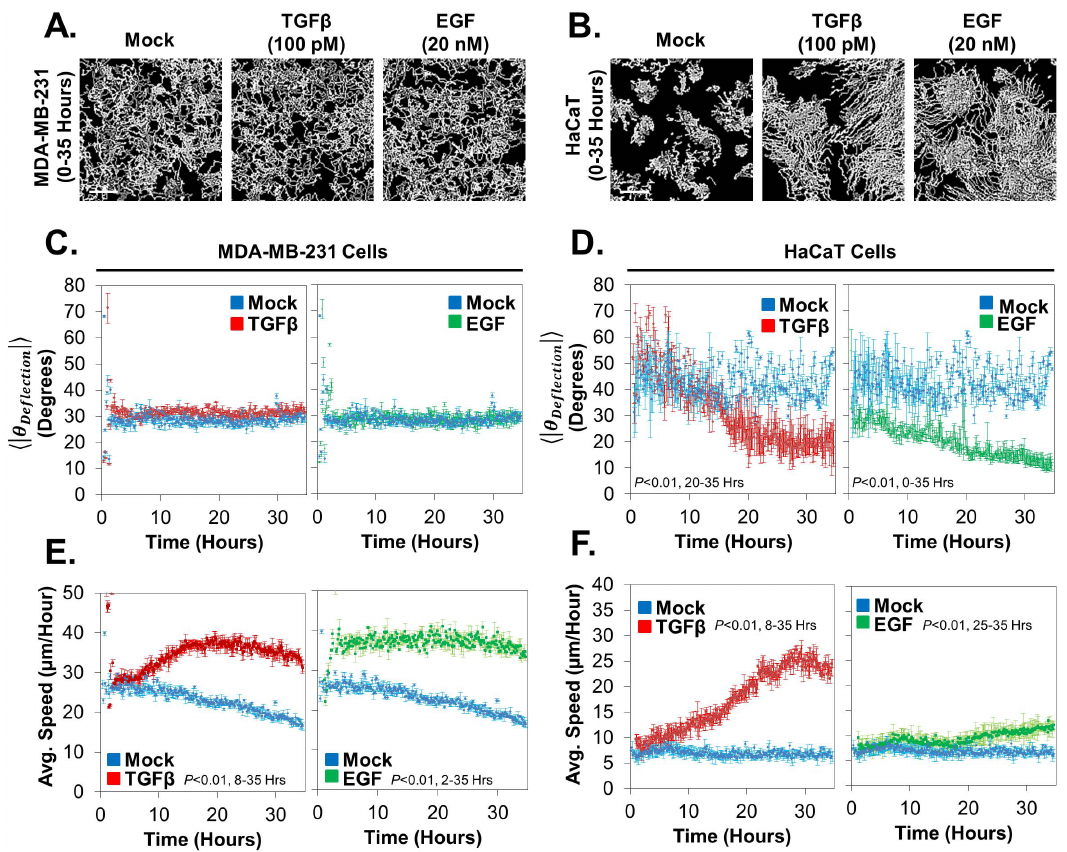
Figure 5. Measuring individual cellular behavior with speed and migration persistence reveals cell type and ligand specific cellular migration behavior. Cellular tracks of low density cells are displayed for treatments of either Mock, TGF b or EGF for MDA-MB-231 cells ( A ) or HaCaT cells ( B ). Calibration bars represent 150 m m. C ) Neither TGF-Beta nor EGF stimulation affects migration persistence in MDA-MB-231cells (top). In contrast, both treatments affect cellular speed, but with different induction kinetics (bottom). D ) In HaCaT cells, both ligand treatments affect migration persistence and cellular speed (top and bottom, respectively). However, EGF stimulates migration persistence with earlier kinetics than that of TGF b (top), and EGF is a poor stimulator of migration speed (bottom, right). Each condition represents greater than 1000 cells.